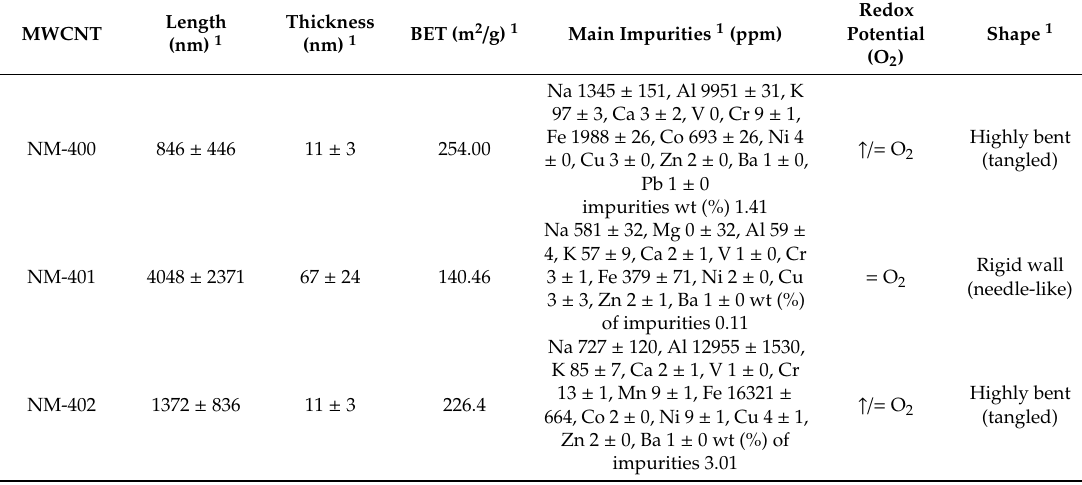
Table 1. Main characteristics of the MWCNT